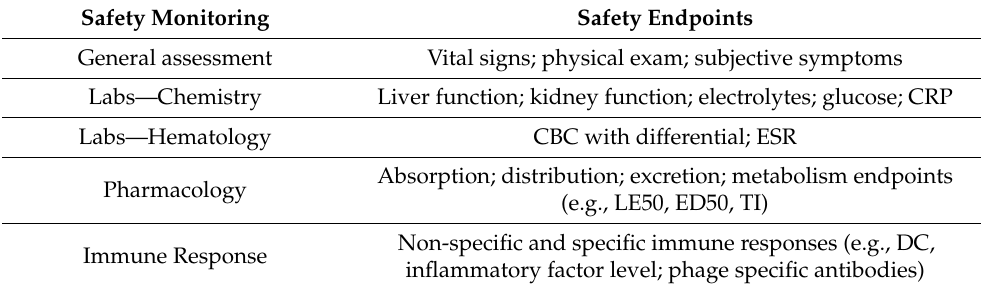
Table 3. Safety endpoints in phage therapy study to be